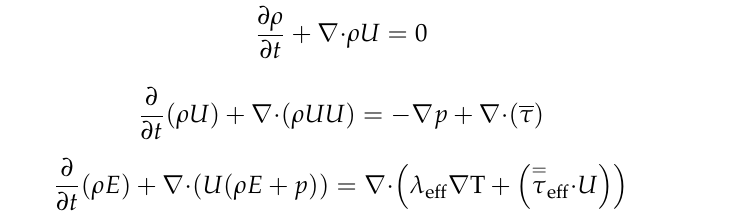
Figure 4. Structural grid of the model: ( a ) Vertical view; ( b ) Front view; ( c ) Side view; ( d ) Local details of ( c ). Table 1. Grid independence verification. Grid Number